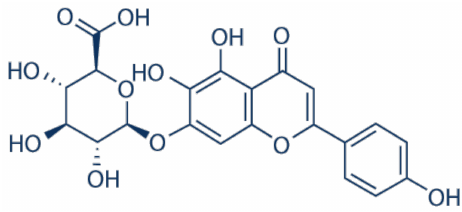
Figure 5. The chemical structure of